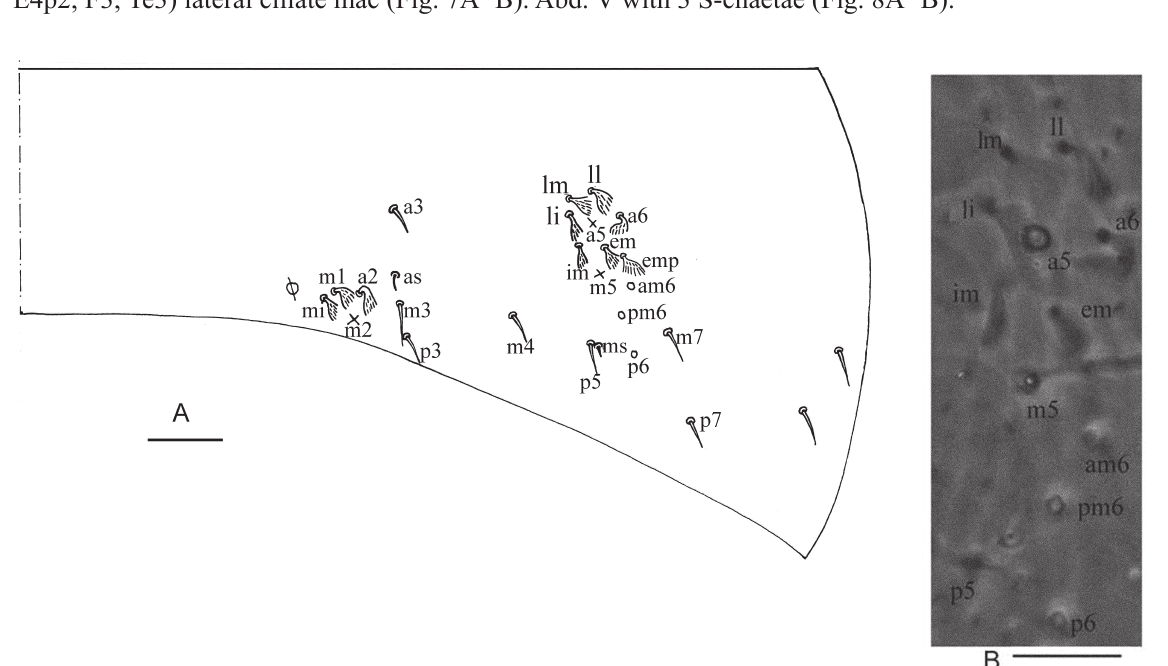
Fig. 6. Lepidocyrtus ( A. ) huizhouensis sp. nov., dorsal chaetotaxy (right side). A . Abd. III. B . Lateral part of Abd. III. Scale bars: 30